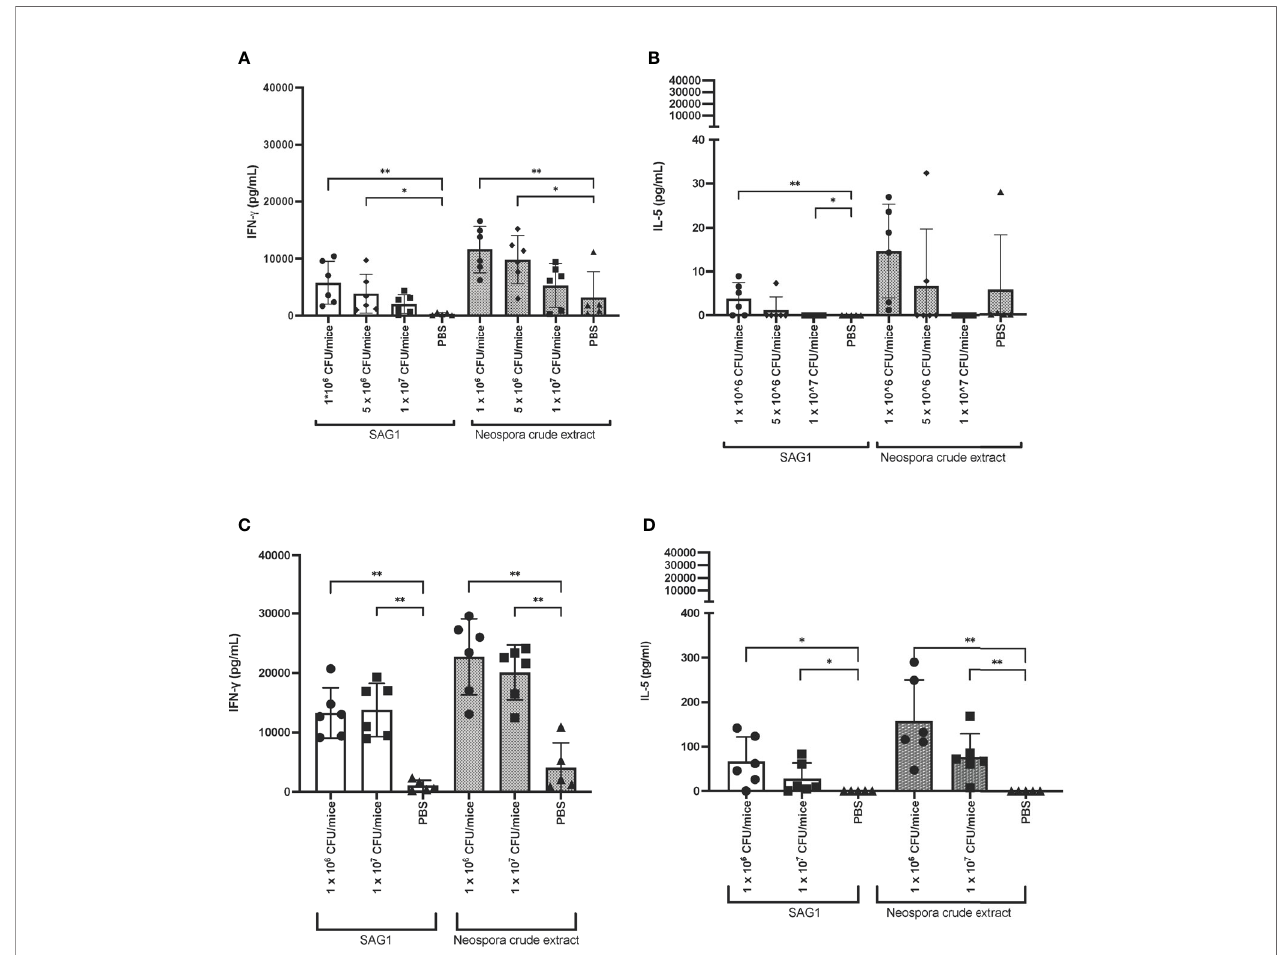
FIGURE 8 | IFN- g and IL-5 response in Lm3Dx_SAG1-immunized mice. (A) IFN- g and (B) IL-5 response of splenocytes isolated from spleens 14 days after the second boost of non-pregnant mice. Splenocytes were stimulated with recombinant NcSAG1 or Neospora caninum crude extract (grey bars). (C) IFN- g and (D) IL-5 response upon stimulation in the pregnancy outcome model. In this experiment, splenocytes of mice were recovered 42 days after the second boost or sham (PBS) injection. Columns represent the median and whiskers the standard deviation. * indicate signi fi cant levels compared to the PBS group: *P ≤ 0.0332, **P ≤ 0.0021 (Mann Whitney-U